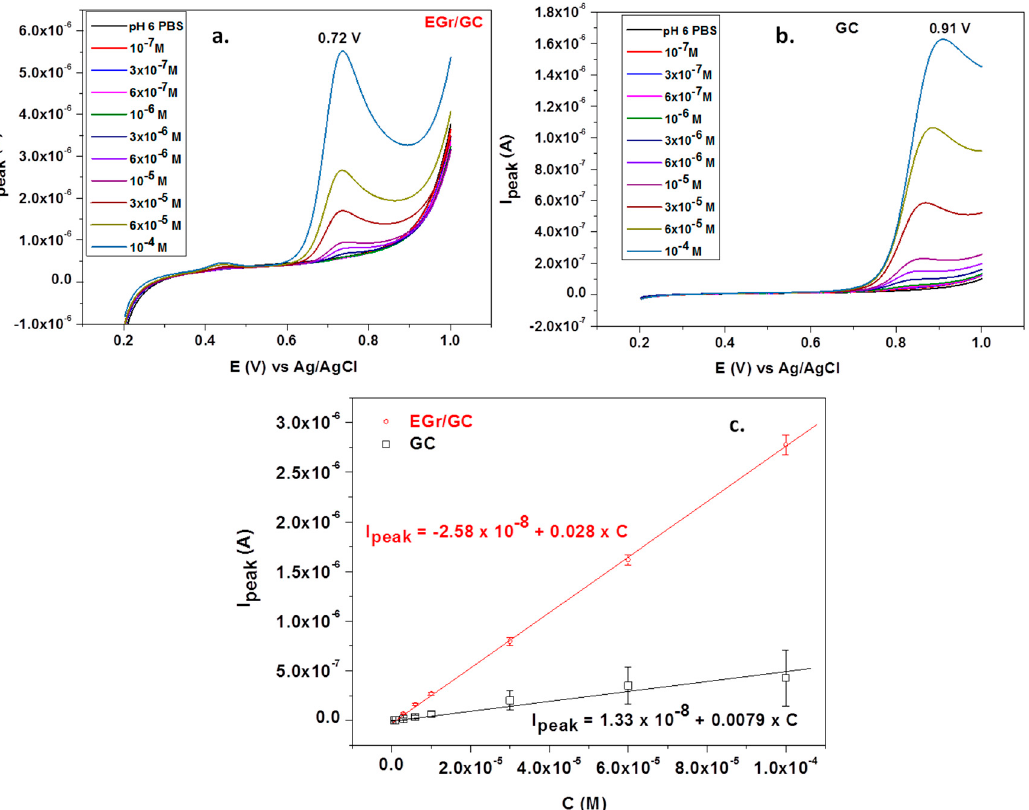
Figure 8. Linear sweep voltammograms recorded with a graphene-modified electrode ( a ) and a bare GC electrode ( b ) in the presence of different concentrations of L ‐ tryptophan (supporting electrolyte: pH 6 PBS; scan rate: 10 mV/s); the corresponding calibration plots for bare GC and EGr/GC electrodes ( c ).